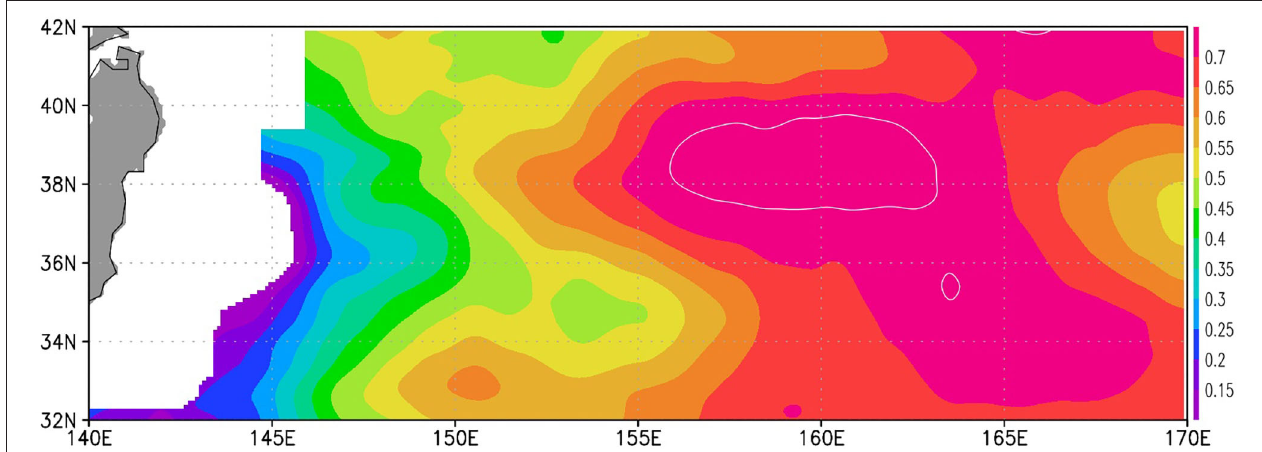
FIGURE 9 | Horizontal map of the square root of the potential predictability (PP) of the simulated 5 ◦ − longitude and 5 ◦ − latitude averaged EKE. The value is plotted at the grid point of the center of the 5 ◦ − longitude and 5 ◦ − latitude area. White contours indicate 0.75. A 13-month running-mean is applied to and the linear trend is removed from EKE before estimating